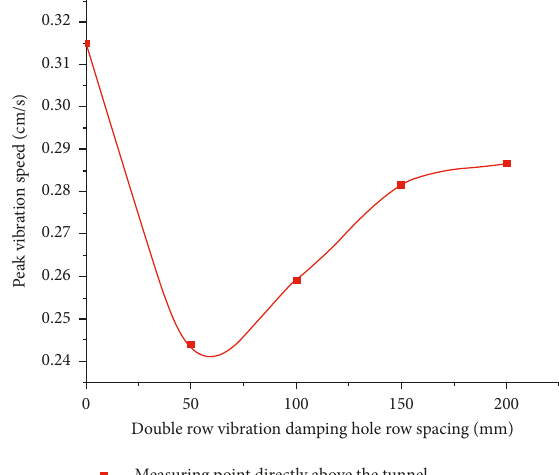
Figure 10: Peak vibration velocity of double-row damping hole row spacing.